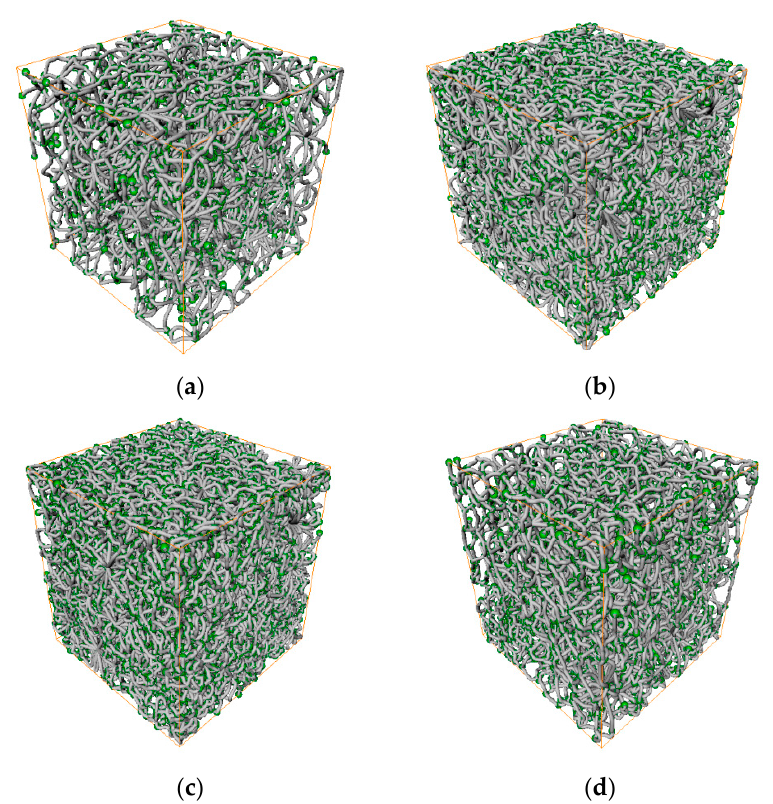
Figure 1. Sandstone three-dimensional pore network (bounding box volume: 3 mm by 3 mm by 3 mm. The pore network is extracted by the skeleton algorithm in the digital rock reconstructed from the X-ray CT scanner): ( a ) 14.1%; ( b ) 16.9%; ( c ) 17.1%; ( d ) 24.6%.